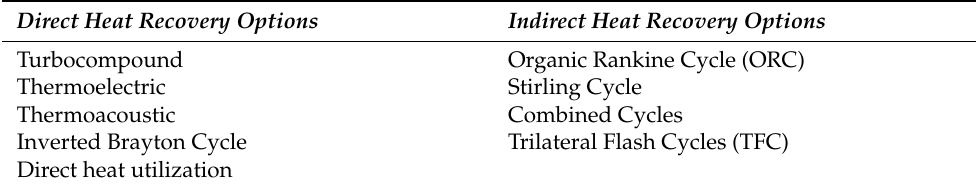
Table 2. Summary of WHR technologies discussed in this